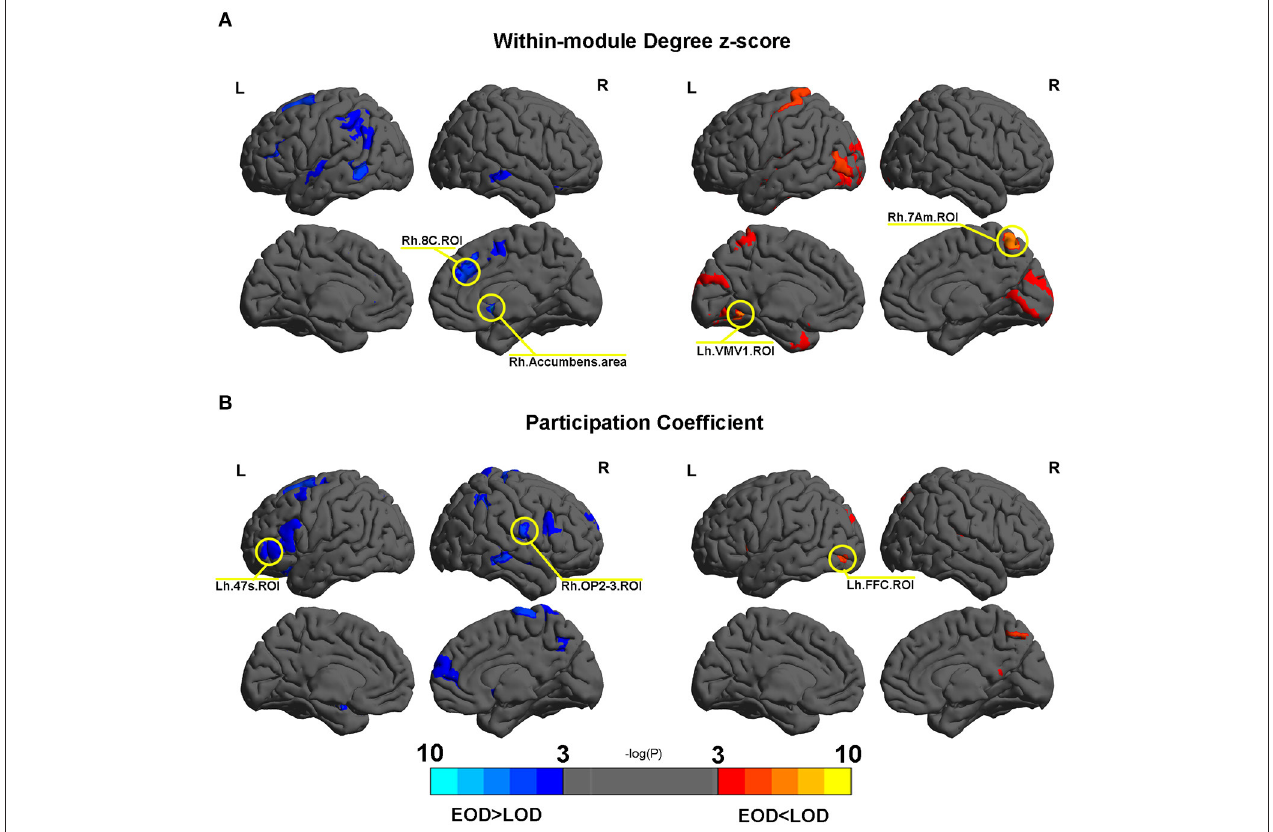
FIGURE 4 | (A,B) The different nodes in the within module degree z-score and participation coefficient in the 2% sparsity network respectively. Mapping was performed using BrainNet Viewer software